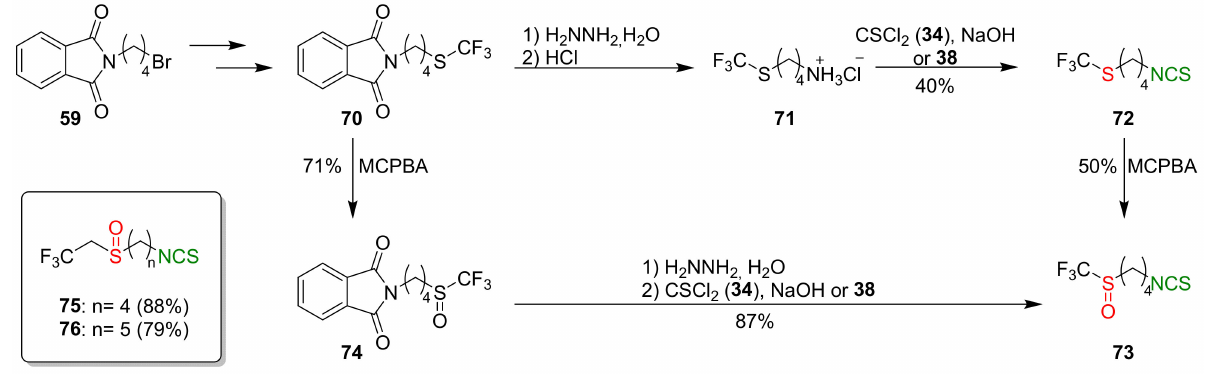
Figure 20. Synthesis of trifluoromethyl ( 73 ) and trifluoroethyl ( 75 – 76 ) analogs of SFN. The ITCs 73 , 75 – 76 , obtained as racemates, were separated on preparative chiral HPLC to the enantiomerically pure products. All three pairs of enantiomers of fluorine-containing analogs 73 , 75 – 76 were tested in vitro for their cytotoxicity against malignant melanoma cell lines Malme-3M and normal skin fibroblast Malme-3. In Table 2, the activity of the most promising compound 75 is presented. Table 2. Cytotoxicity of SFN and its fluorine-containing analogs 75 .